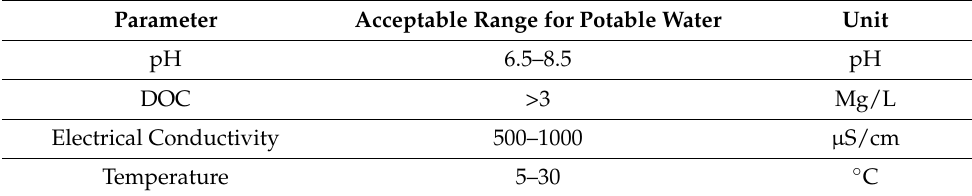
Table 1. Some water quality parameters and acceptable ranges.